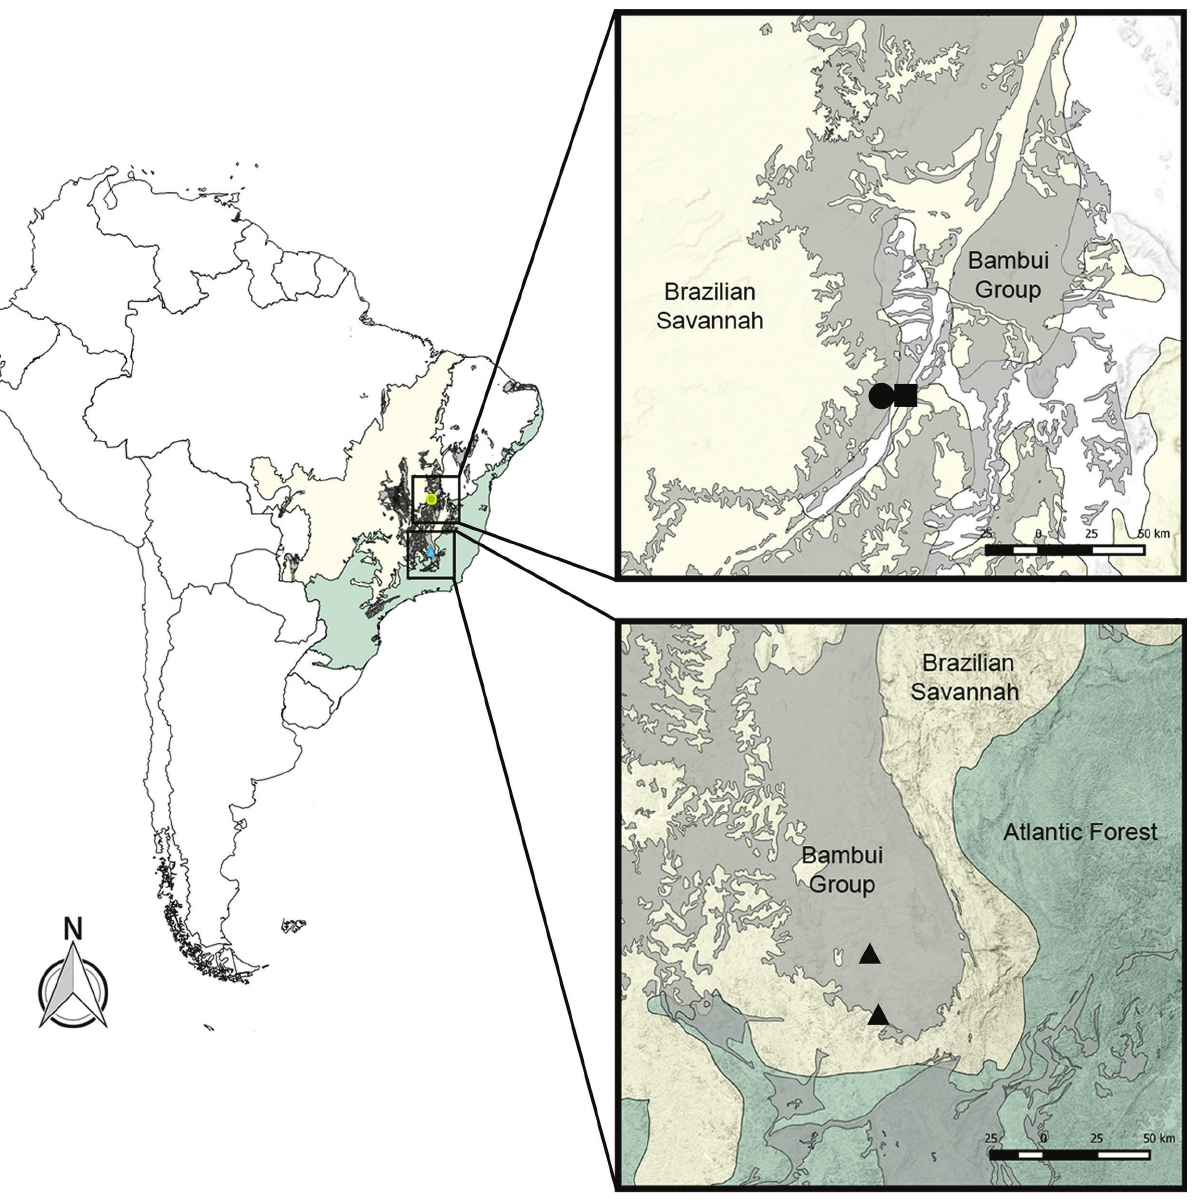
Figure 14. Map of distribution.  , Xangoniscus odara n. sp.;  , Trichorhina cipoensis n. sp.; ▲ , Trichorhina pataxosi n.